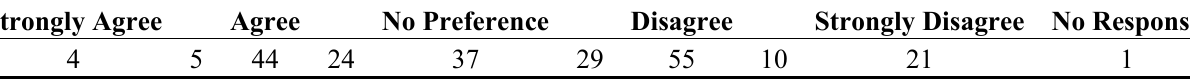
Table 3. Responses to the statement “I would trust computer analysis (without human involvement) of planetary science